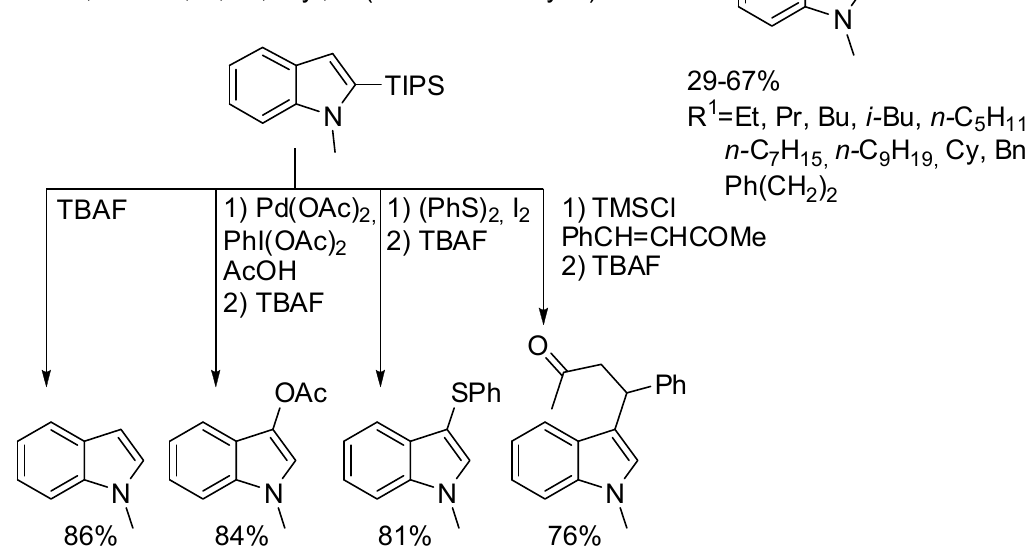
Scheme 6. Cobalt(III) catalyzed indolization with N -alkyl- N